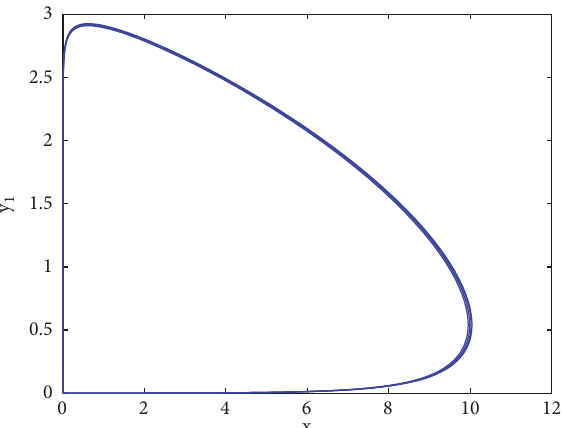
Figure 1: The two-dimension phase diagram of the stable solution of system (30) under the condition 𝑟 = 1 , 𝑏 1 = 0.8 , 𝑘 = 2 , 𝑄 = 1.2 , 𝑎 2 = 1 , 𝑎 = 1.2 , 𝑑 = 0.5 , and 𝑐 = 0.01 . 1 1 1